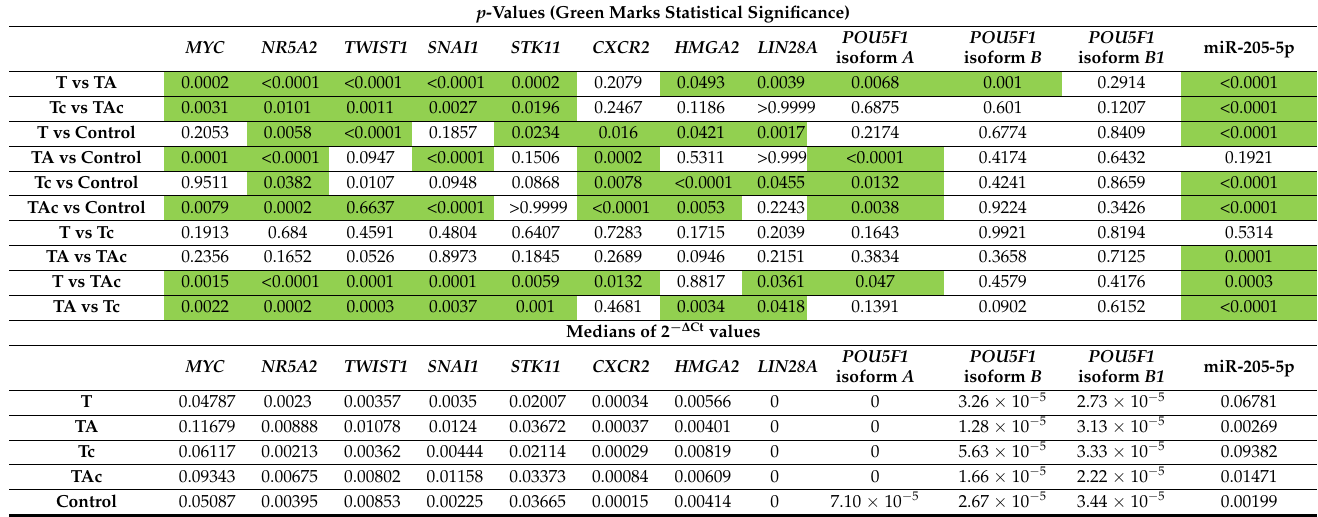
Table 2. Gene expression in tumor-adjacent tissues (TA) and tumors in patients with EC (T and Ts) and in endometrial tissue (TA and TAc) in cancer-free patients with leiomyoma (Control). p -Values (Green Marks Statistical Significance)